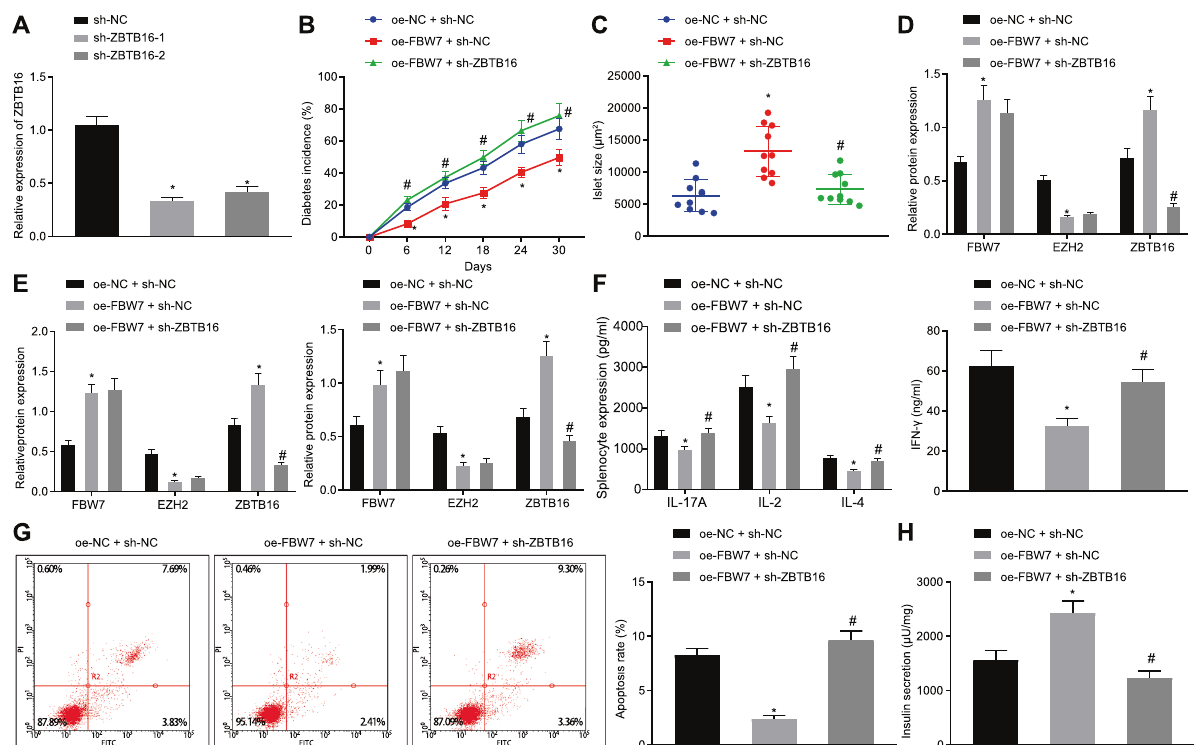
Fig. 5 FBW7 inhibits T1D occurrence via EZH2/ZBTB16 in vivo and in vitro. A RT-qPCR detection of ZBTB16 mRNA level in each group, * p < 0.05 vs. the OE-NC group. B The diabetes incurrence in each mouse model group, * p < 0.05 vs. the OE-FBW7 + sh-NC group. C The islet size in each mice model group, * p < 0.05 vs. the OE-FBW7 + sh-NC group. D Western blot detection of FBW7, EZH2, and ZBTB16 expression in islet, * p < 0.05 vs. the OE-FBW7 + sh-NC group, # p < 0.05 vs. the OE-FBW7 + sh-NC group. E Western blot detection of FBW7, EZH2, and